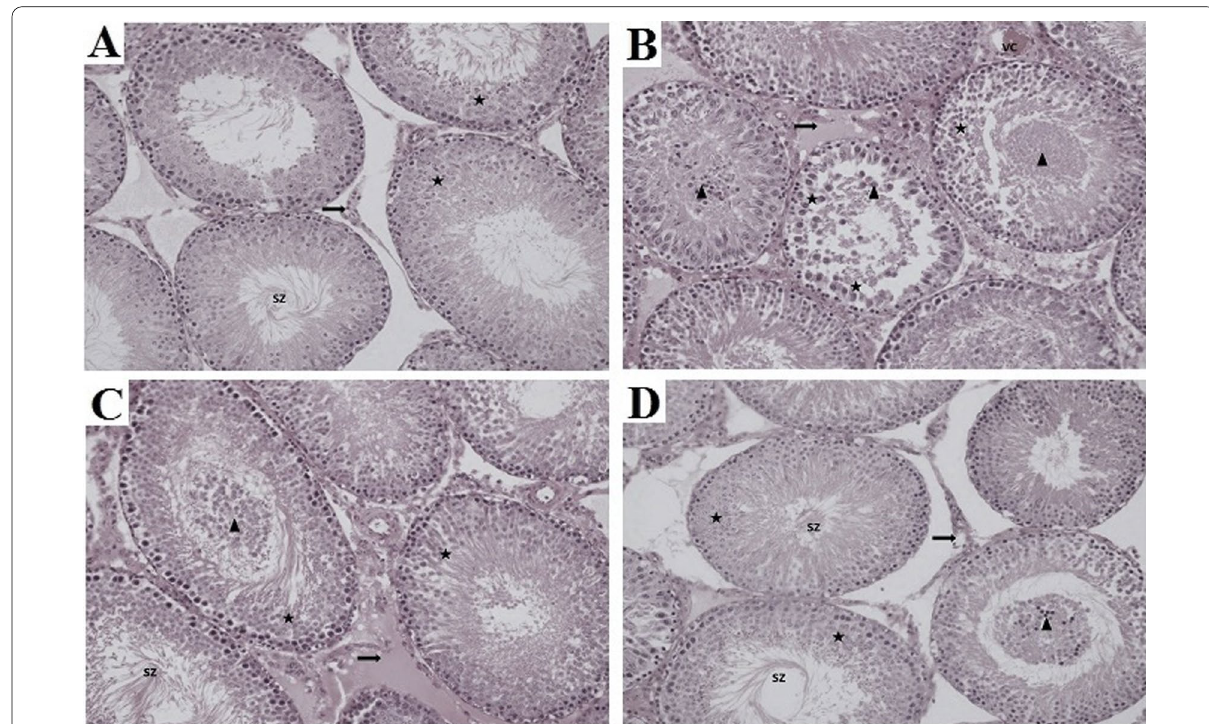
Fig. 1 Histopathological images of testicular tissues of groups ( 200, H&E staining). Sham control group ( A ) SZ: spermatozoon, black star: × seminiferous tubule germinal epithelium, black arrow: intertubular area. T/D group ( B ) VC: vasocongestion in the intertubular area, arrowhead: germinal epithelial cells, black star: seminiferous tubule germinal epithelium, black arrow: edema in the intertubular area. T/D 50 mg/kg VA ( C ) + SZ: spermatozoon, black star: seminiferous tubule germinal epithelium, arrowhead: germinal epithelial cells, black arrow: edema in the intertubular area. T/D 100 mg/kg VA ( D ) SZ: spermatozoon, black star: seminiferous tubule germinal epithelium, black star: seminiferous tubule germinal + epithelium, arrowhead: germinal epithelial cells, black arrow: intertubular